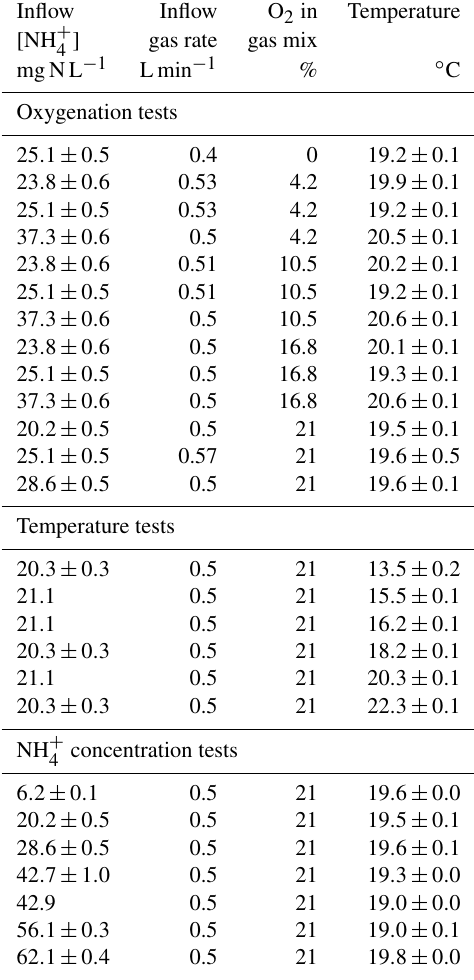
Table 1. Detailed average conditions ( ± standard deviation) of oxy- genation, temperature and concentration